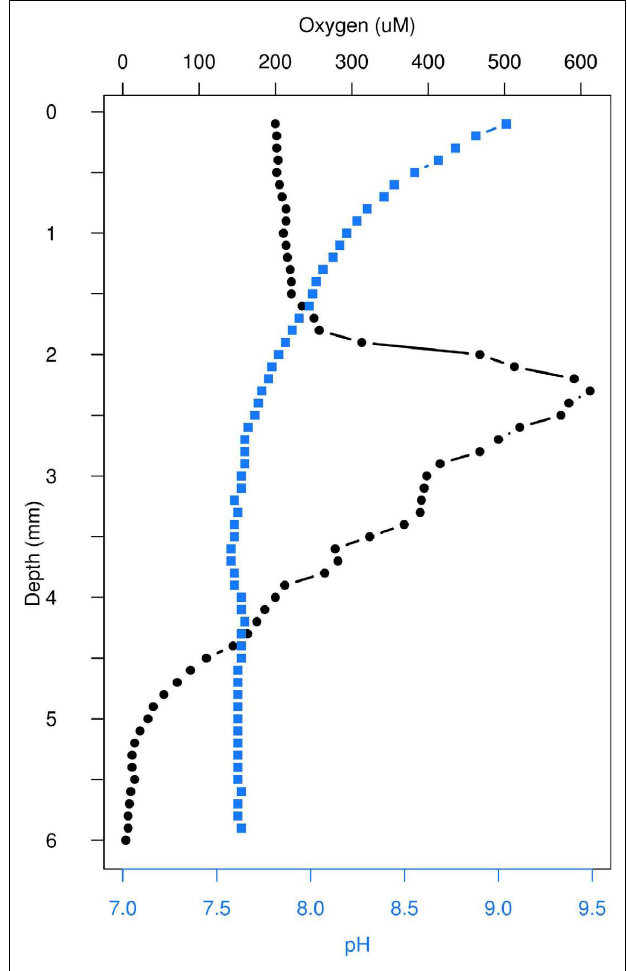
FIGURE 2 | In situ microsensor depth profile for oxygen concentration and